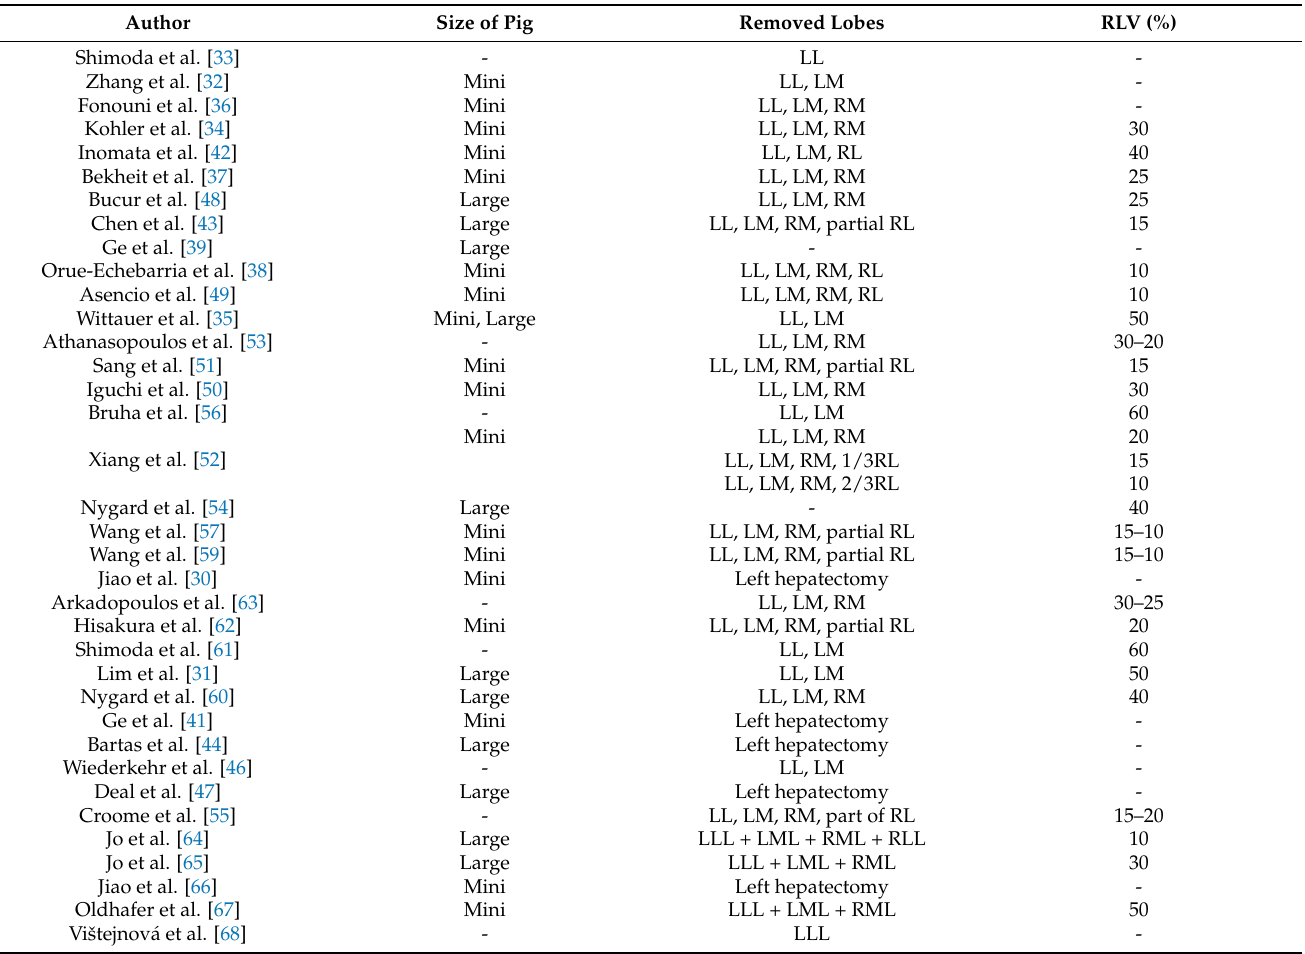
Table 2. Remnant liver volume in partial